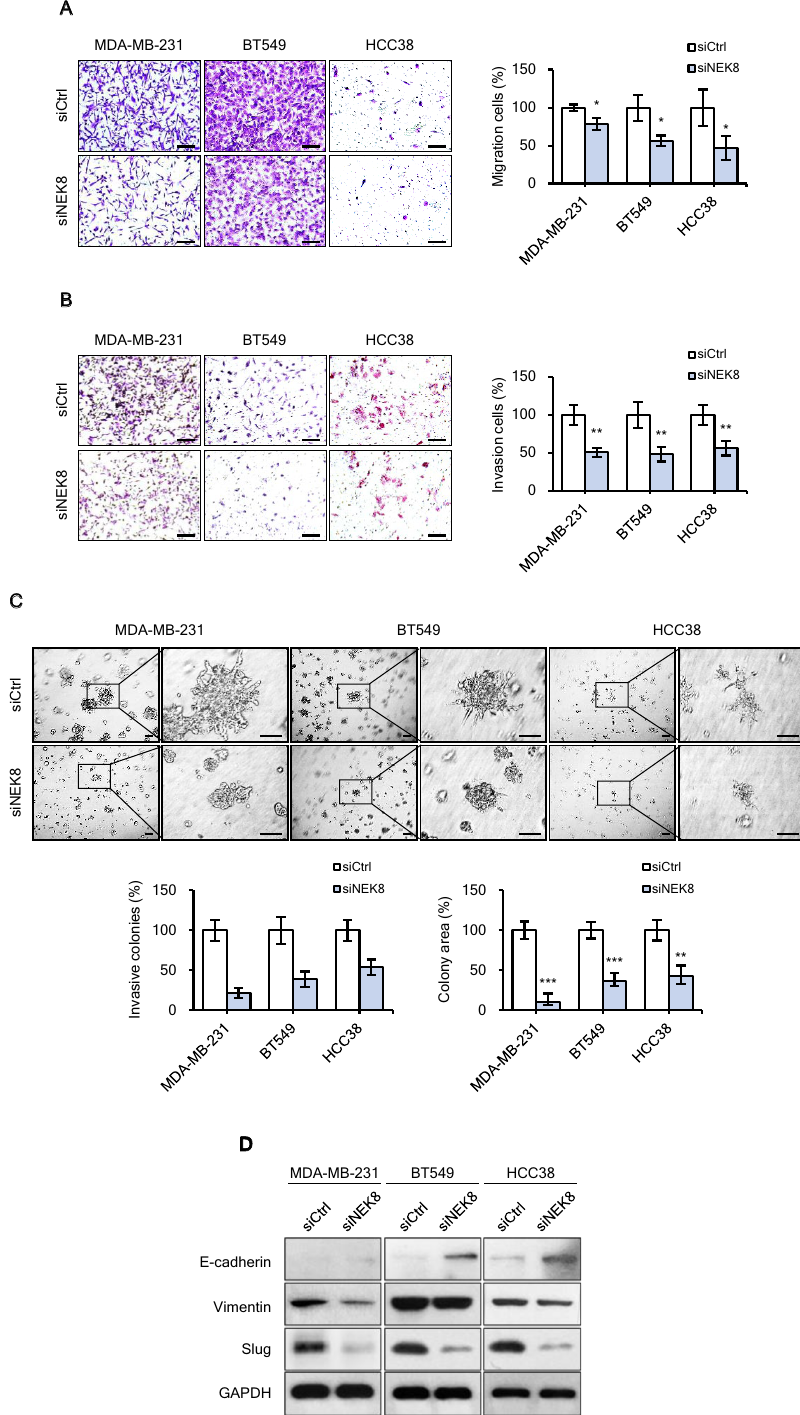
Figure 3. Knockdown of never in mitosis gene A-related kinase-8 (NEK8) inhibits the migration and invasion of breast cancer cells. ( A ) Migration and ( B ) invasion of MDA-MB-231, BT549, and HCC38 cells determined using Transwell assays (×200 magnification; scale bar, 50 μm). ( C ) Cells were grown on 3D Matrigel for 5 days; then, branching structures were counted using phase-contrast microscopy (×40 magnification; scale bar, 100 μm). The graph is representative of at least three independent experiments (n ≥ 3), where each experiment was performed in triplicate. Error bars, standard deviation; *** P < 0.001, ** P < 0.01, * P < 0.05. ( D ) Expression of the epithelial-mesenchymal transition-related proteins E-cadherin, vimentin and Slug using western blotting. GAPDH was used as a loading control. The figure is representative of at least two independent experiments (n ≥ 2). The blots were cut prior to incubation with